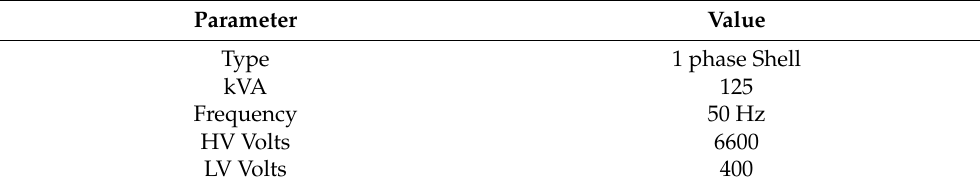
Table 1. The transformer main technical data.